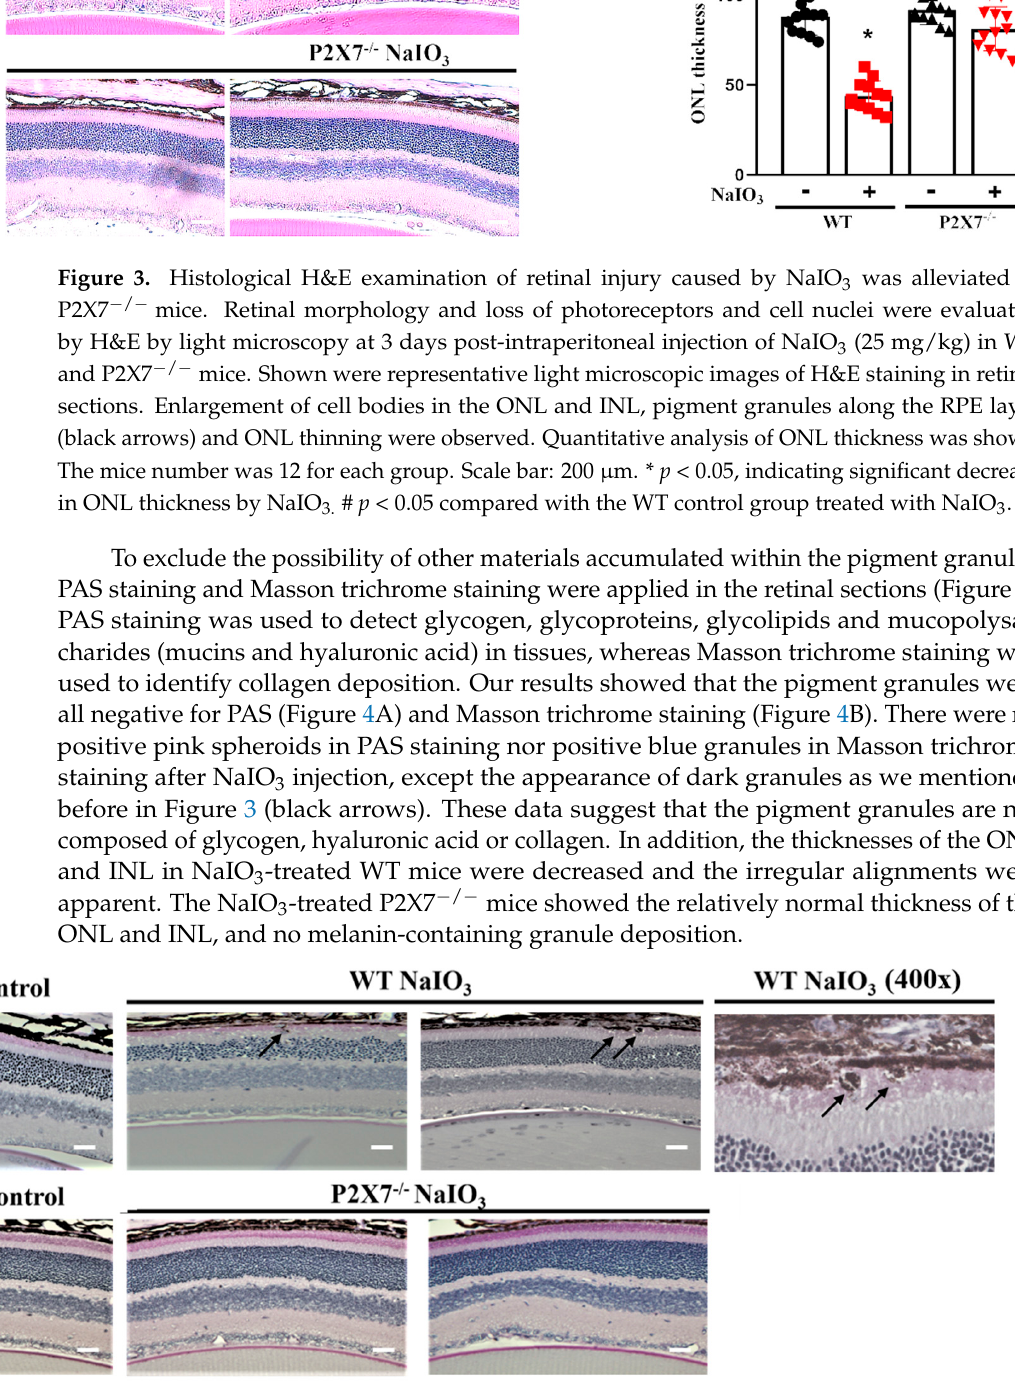
Figure 4. Histological examination of PAS and Masson trichrome staining. Representative light mi- croscope images of PAS ( A ) and Masson trichrome ( B ) staining of retinal sections in WT and P2X7 − / − mice at 3 days post-intraperitoneal injection of NaIO 3 (25 mg/kg) were shown. The visible retinal pigment granules were shown as black arrows in both PAS ( A ) and Masson trichrome ( B ) staining. The mice number for PAS staining was 5 for each group and for Masson trichrome staining was 7 for each group. Scale bar: 200 μ m. 3.2. P2X7 Knockout Reduces NLRP3, IL-1 β and IL-6 Gene Expression in Retinal Tissues after NaIO 3 Injection The effects of NaIO 3 on gene expression relating to inflammation were measured in the isolated retina. Treatment with 25 mg/kg NaIO 3 for 36 h triggers inflammatory re- sponses in the retina of WT mice, as evidenced by the increased mRNA levels of NLRP3, IL-1 β and IL-6. In contrast, P2X7 − / − mice displayed a significant attenuation of these gene expressions after NaIO 3 treatment (Figure 5A). Furthermore, we collected the serum after 3 days of NaIO 3 injection, and measured IL-1 β , TNF α and IL-6 protein levels using ELISA. We found that only the IL-6 protein level was increased in the WT NaIO 3 group, and this response was reduced in the P2X7 − / − NaIO 3 group (Figure 5B).